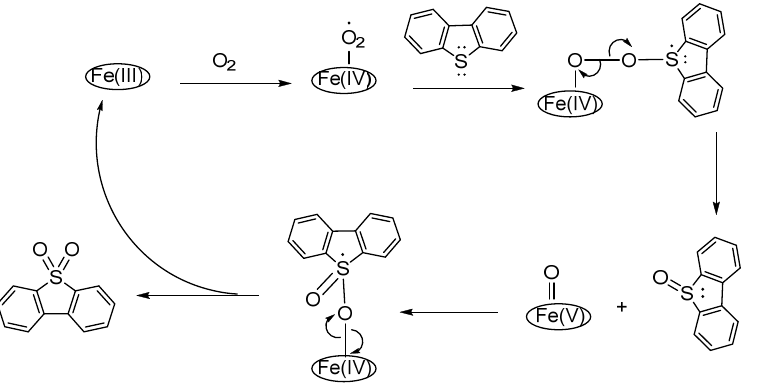
Figure 8. Proposed mechanism for DBT oxidation using Fe(III)Pc(NO 2 ) 3 @SWCNT as catalyst (Adapted form [56]).